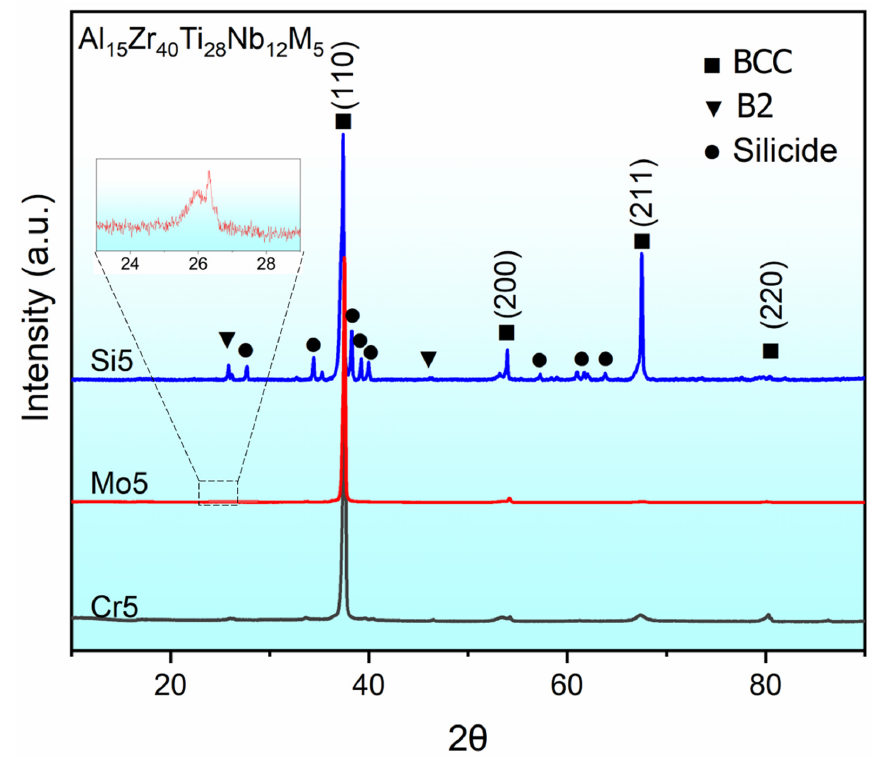
Figure 3. The XRD pattern of the Al 15 Zr 40 Ti 28 Nb 12 M 5 (Cr, Mo, Si) HEAs.